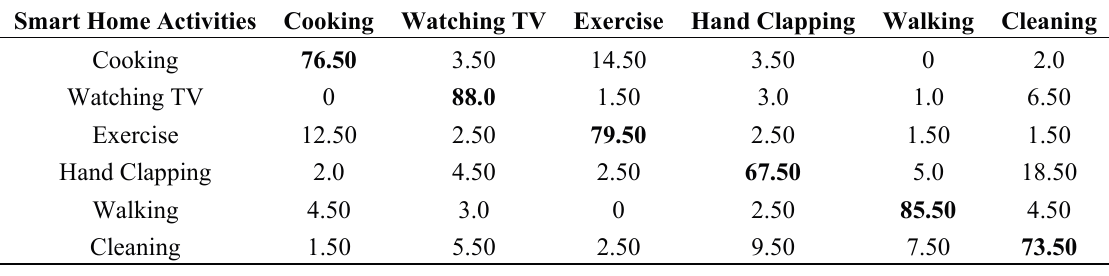
Table 3. Confusion matrix based on recognition results of smart home activities using PC features of depth silhouettes.